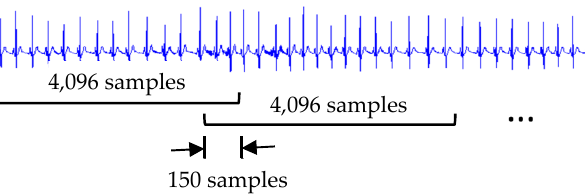
Figure 2. Illustration of segmentation of the electrocardiogram (ECG) recording.